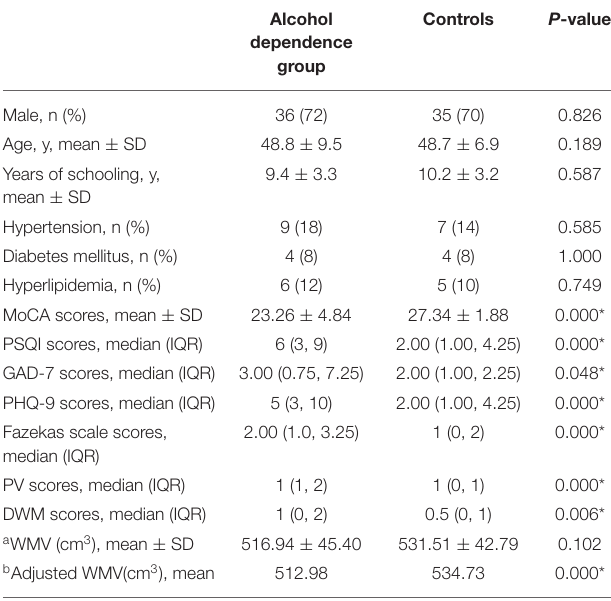
TABLE 1 | Clinical data of alcohol dependence patients and